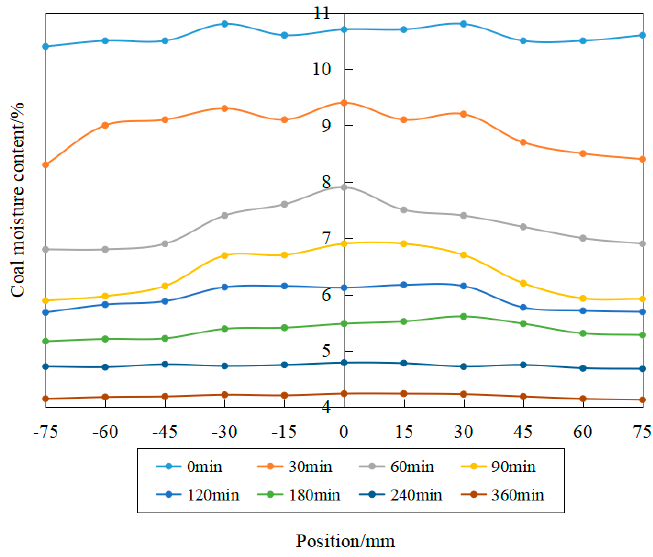
Figure 7. Characteristics of moisture distribution during the drying process.